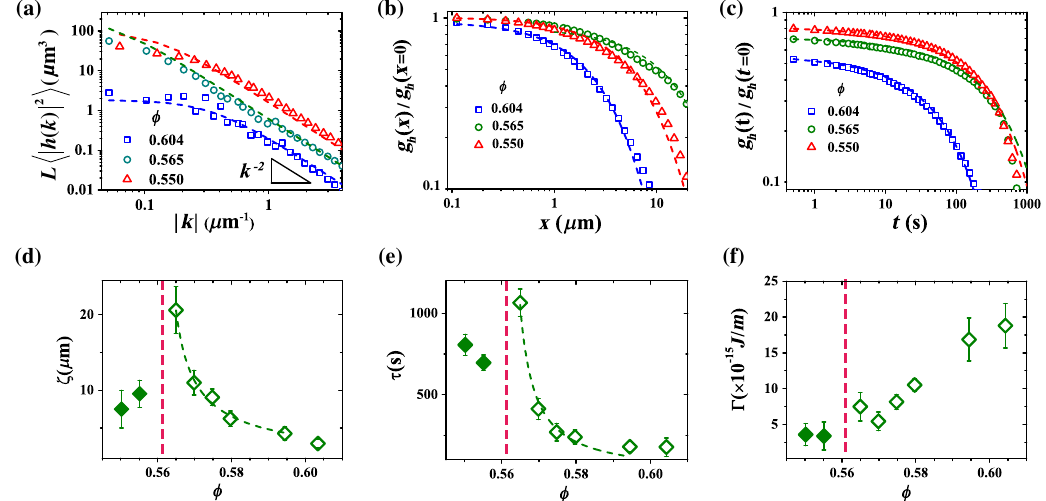
FIG. 5. Correlations and stiffness of the grain boundary with a mismatch angle θ ¼ 22 ° at different volume fractions. (a) Power spectra fitted with Eq. (A3) (dashed curves). (b) The normalized spatial correlation g ffiffiffiffiffiffi p 0 Þ fitted with erfc ð t Þ =g t= τ correlation g Þ . (d) The correlation length fitted with ξ ¼ ξ 0 j½ð ϕ R − ϕ Þ = ϕ (cid:2)j − ν , where ν ¼ 0 . 74 (cid:3) 0 . 04 , h ð h ð ϕ 0 . 561 , and ξ 0 . 52 (cid:3) 0 . 08 μ m. (e) The relaxation time fitted with τ ¼ τ 0 ¼ R ¼ and τ 0 ¼ 5 . 9 (cid:3) 2 . 3 s. (f) The stiffness obtained from the fitting in panel (a). Filled symbols in panels (d) – (f) represent the properties of two solid-liquid interfaces of the melted grain